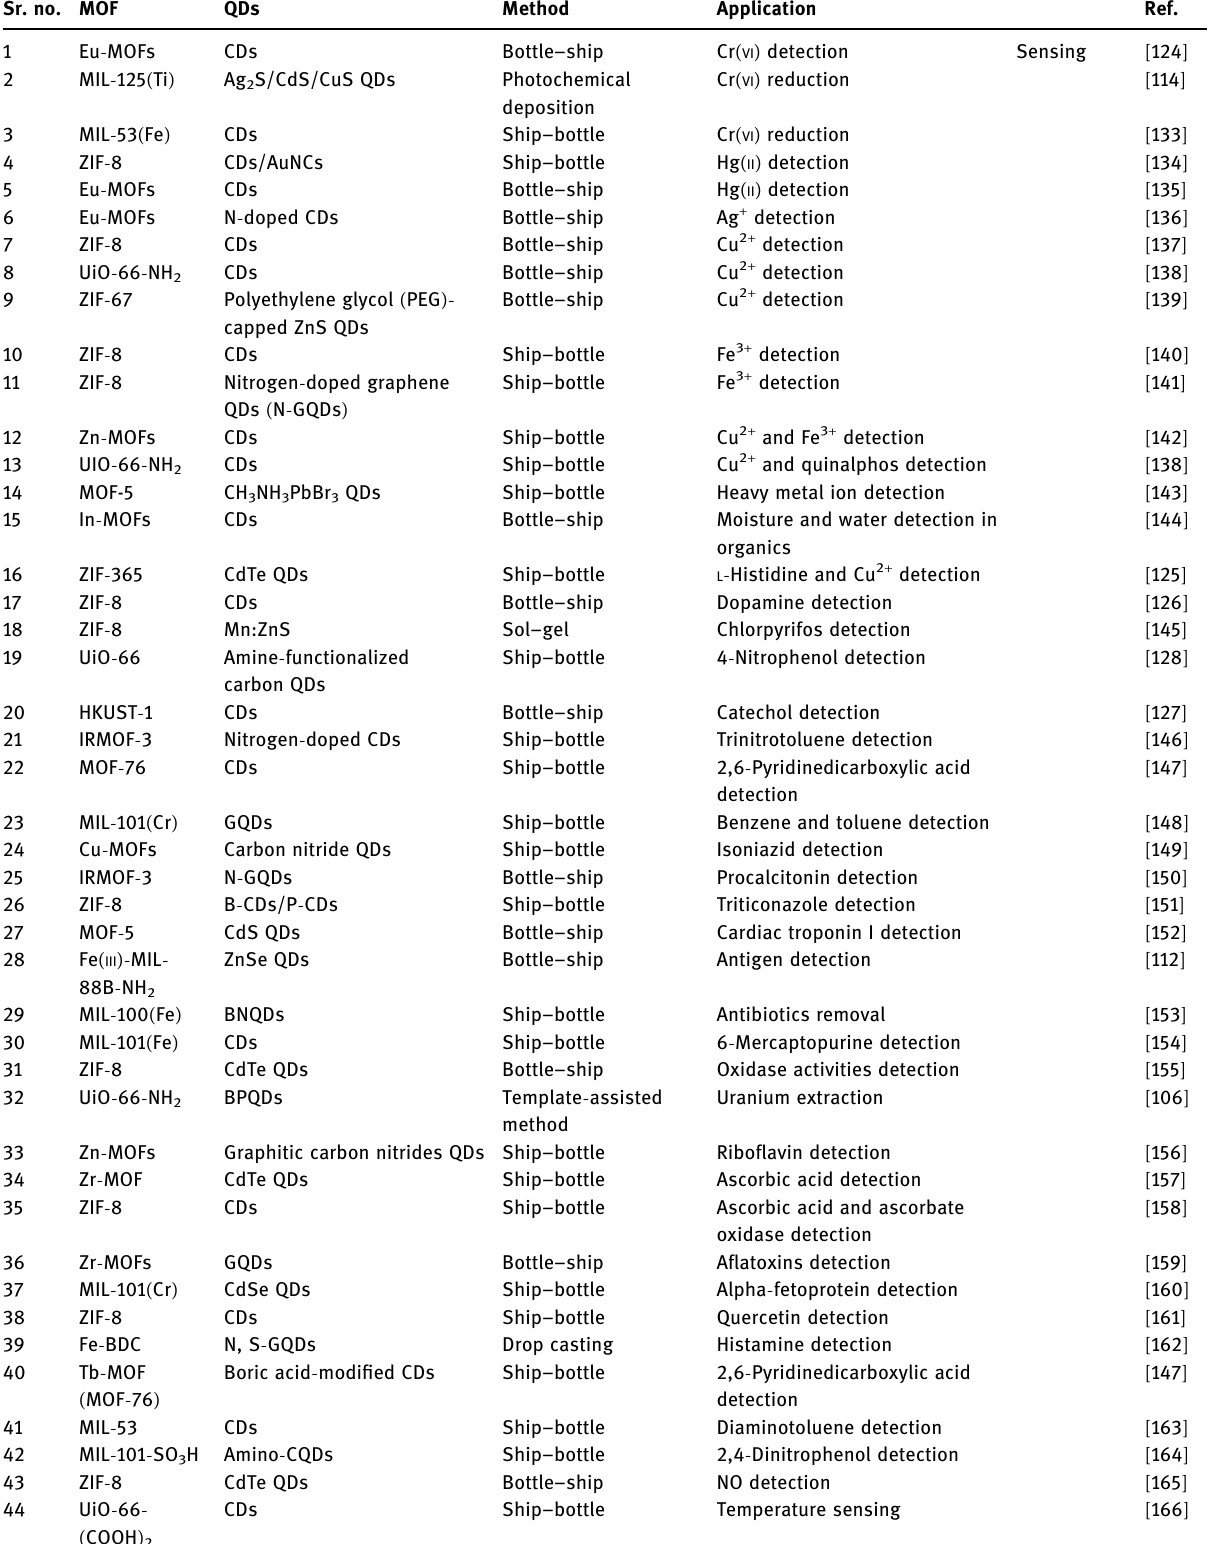
Table 1: List of documented QDs@MOF, including the type of QDs and MOF, utilized their preparative methods and their potential applications in various fi